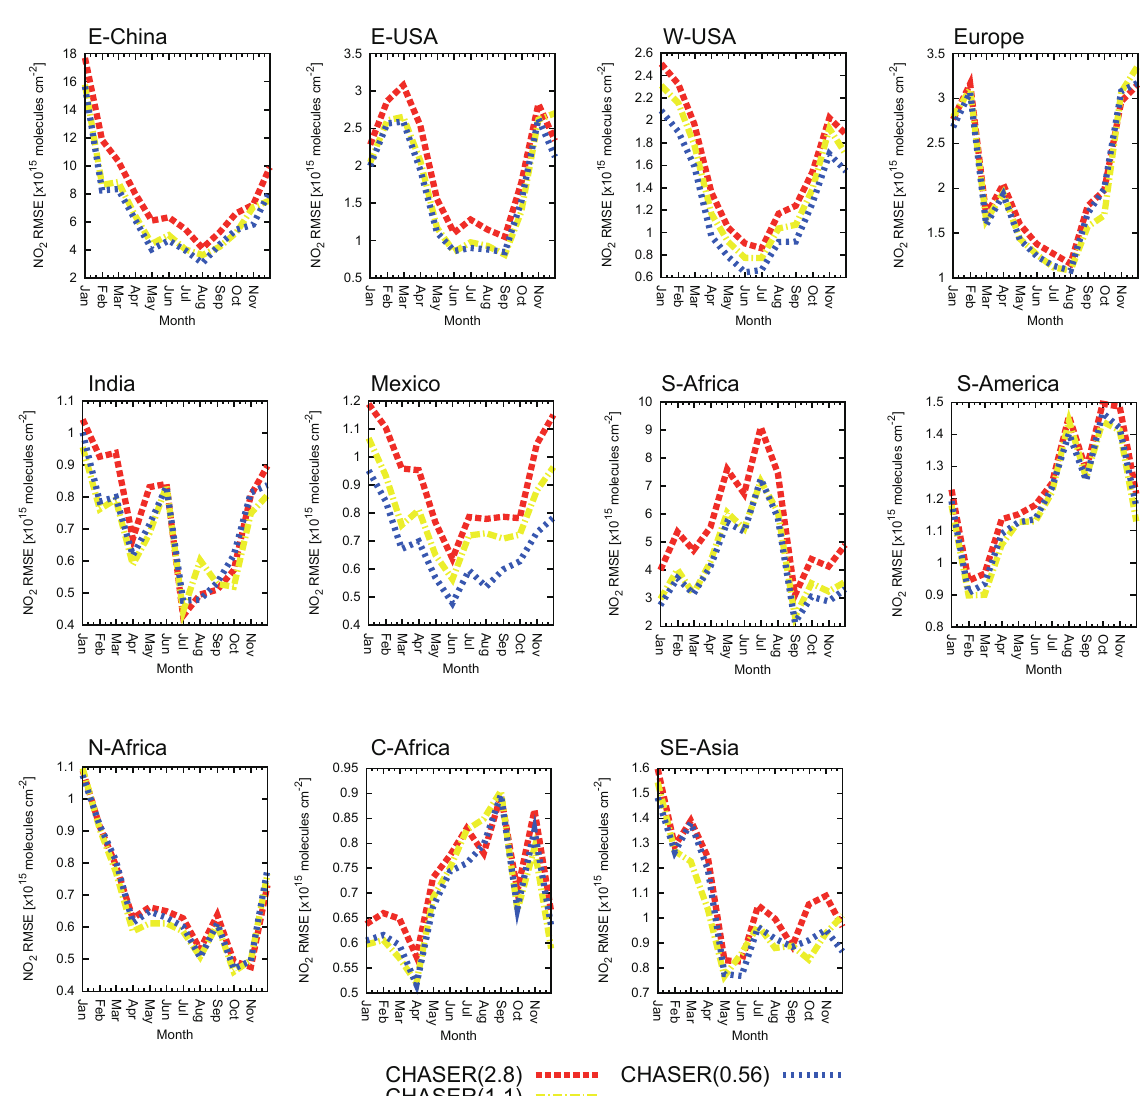
CHASER(2.8) CHASER(0.56) CHASER(1.1)